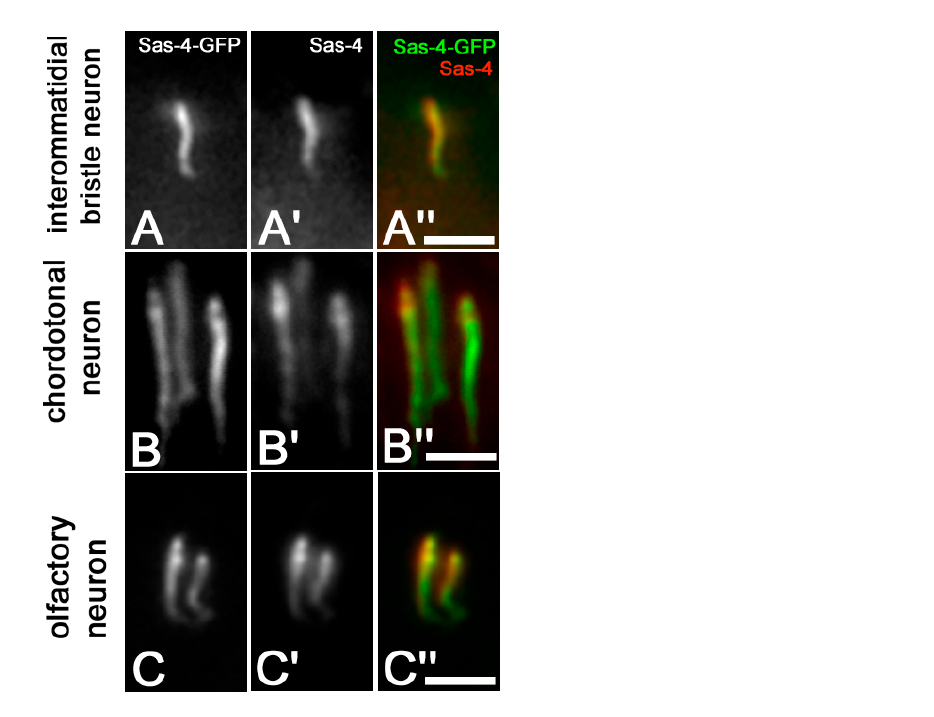
the eye imaginal discs of Sas-4 mutant pupae at 45 h AFP displayed distinct interomma- tidial bristles (Figure 7C) filled by longitudinal bundles of microtubules but the centrioles were lacking (Figure 7D).